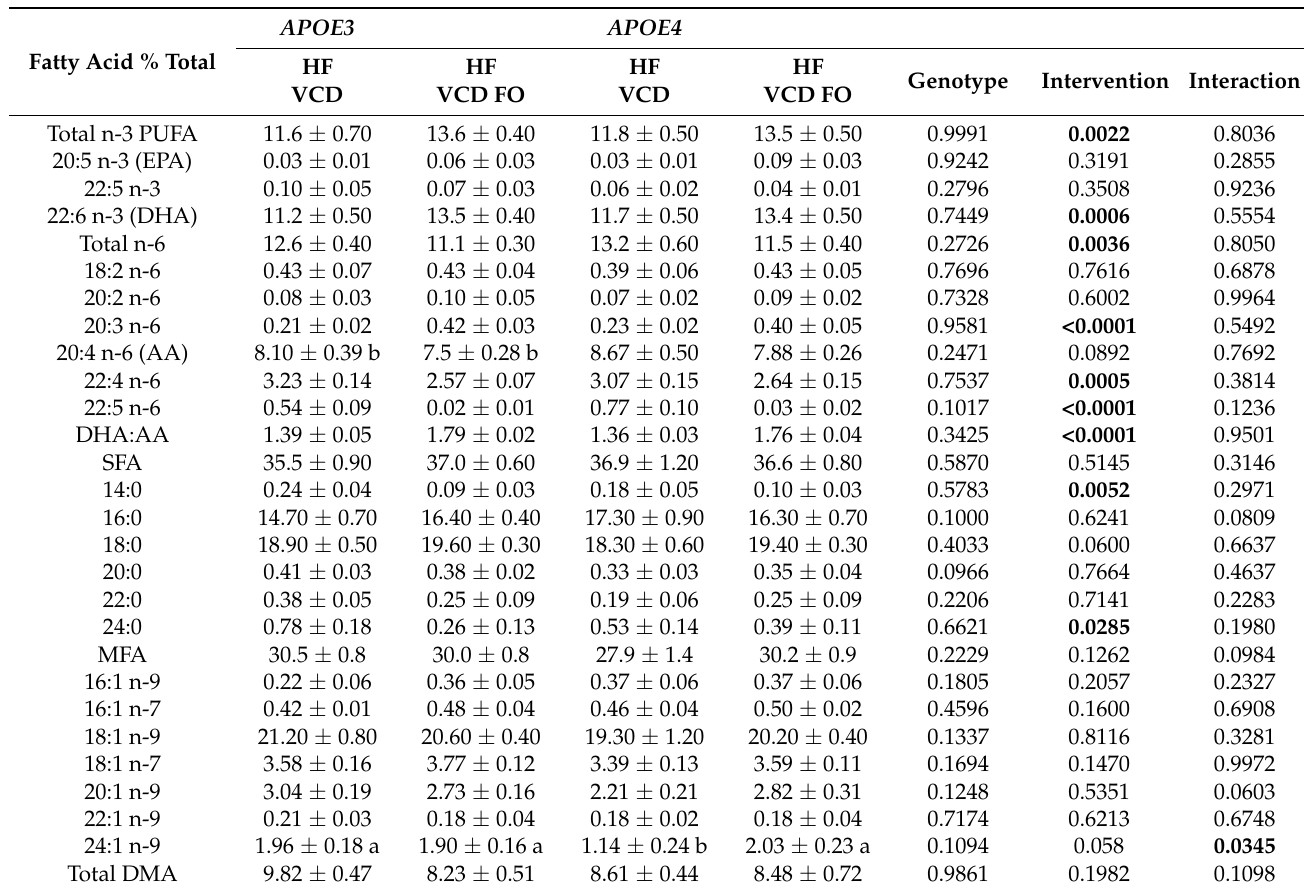
Table 1. Brain fatty acid